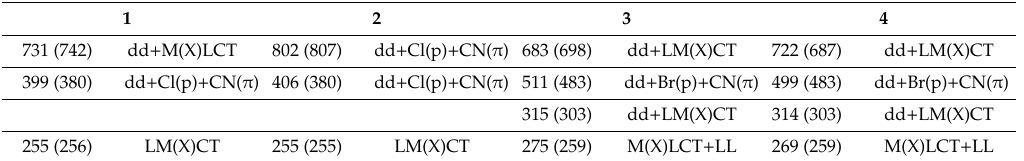
Table 4. The main excitations ( λ max [nm] and type) according to the TD-DFT calculations for compounds 1 – 4 in acetonitrile. The experimental λ max values are given in